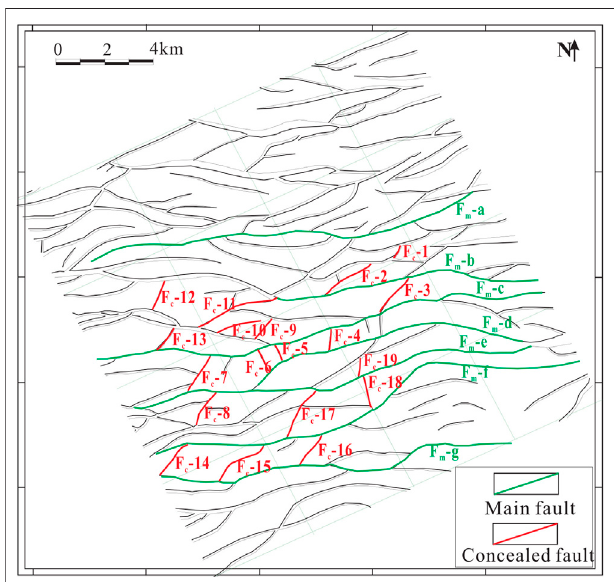
FIGURE 5 | The T 31 structural map of Huawa area including main faults and concealed faults.